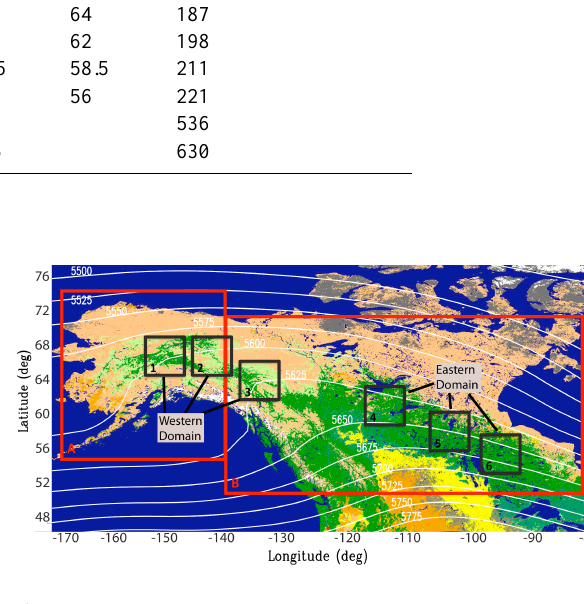
to other forested regions across North America (Stocks et al., 2002; Boles and Verbyla,